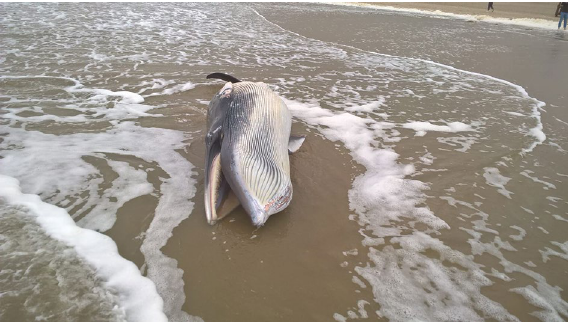
Figure 1. Photograph of the common minke whale ( Balaenoptera acutorostrata ) that washed ashore on the 8th of July 2019 at Texel, the Netherlands. Photograph by Pierre Bonnet (Ecomare,